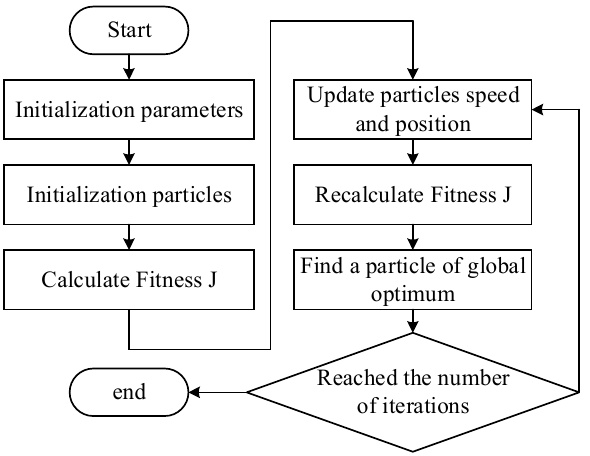
Figure 3. Solution space of particle swarm optimization.